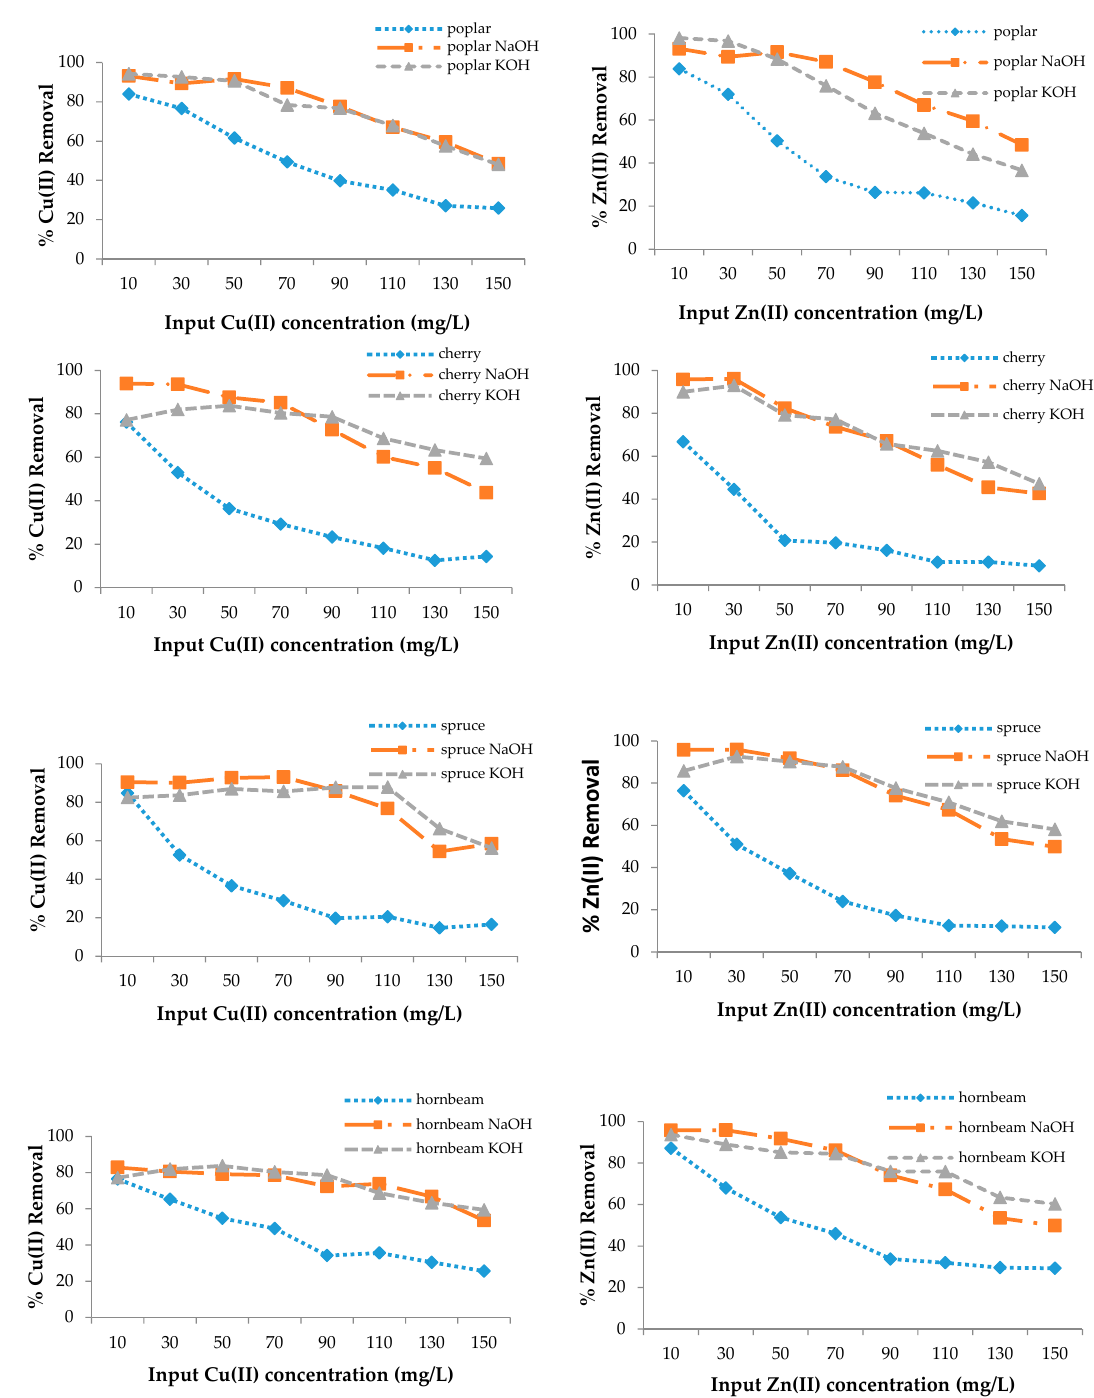
Figure 3. The removal efficiency for Cu(II) and Zn(II) with wooden sawdust .